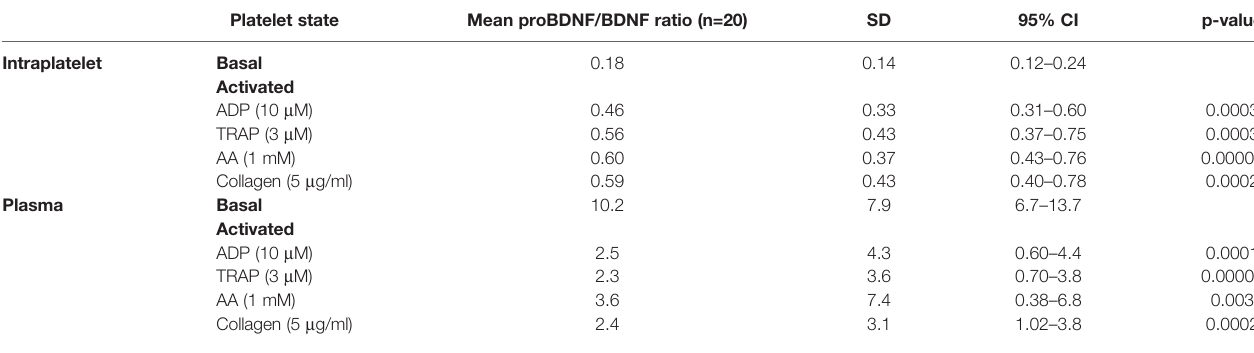
TABLE 2 | proBDNF/BDNF ratio as a function of platelet activation